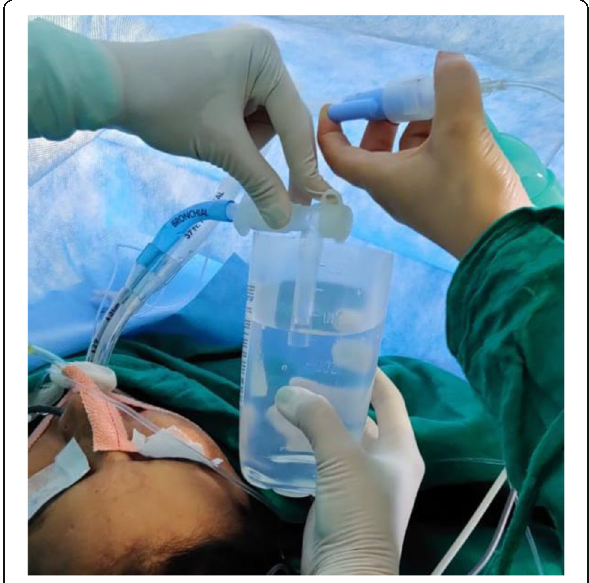
Fig. 2 Checking for adequate seal by water bubble